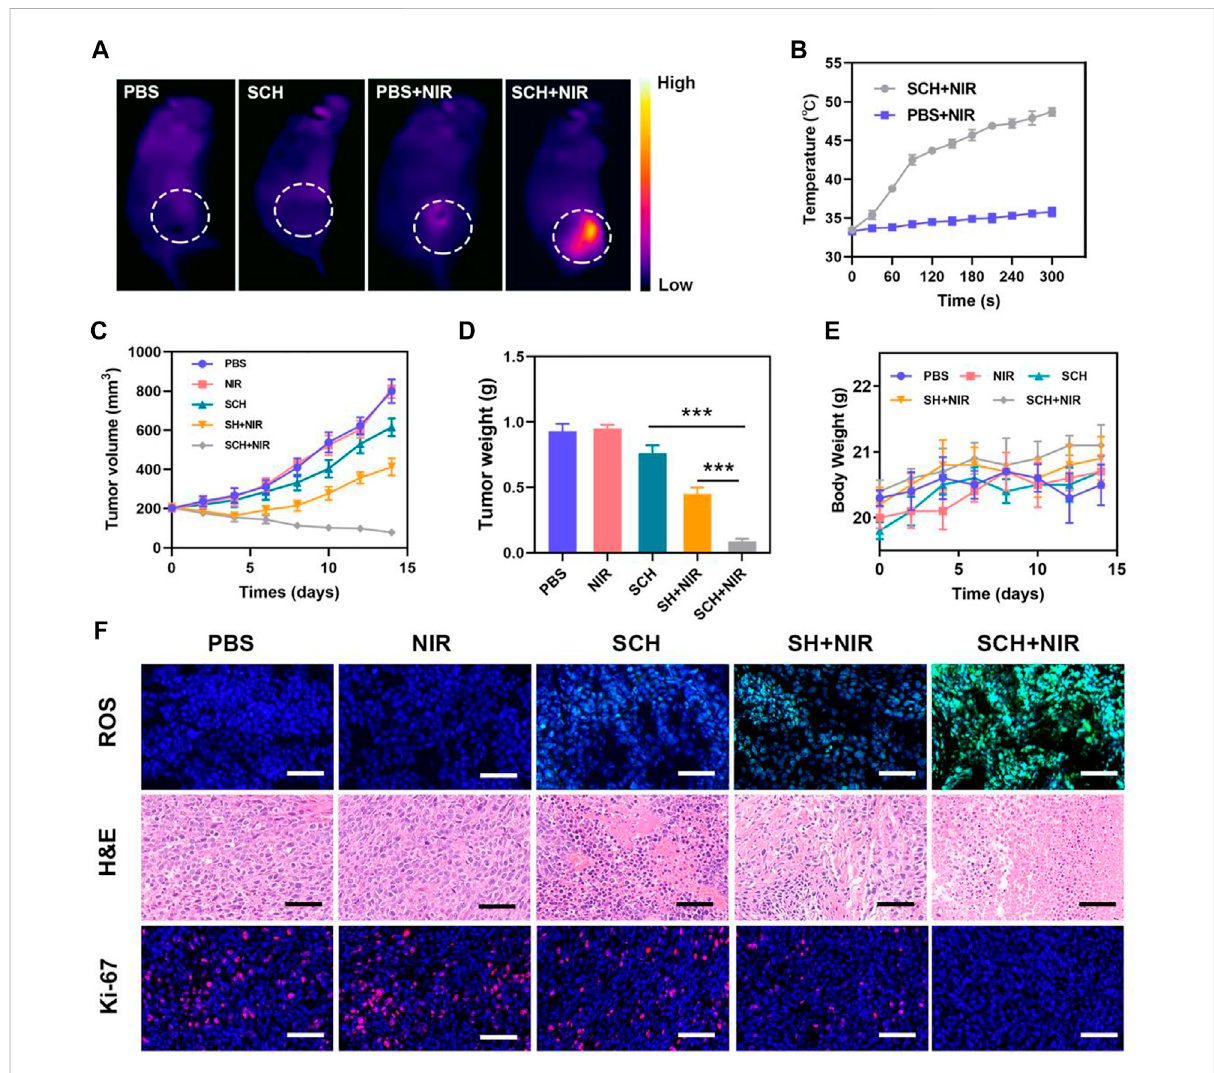
FIGURE 3 (A) Infrared thermal images of tumors in the speci fi ed treatment groups. (B) After being irradiated with 808 nm laser (0.5 W cm − 2 ) for 5 min, the temperature elevates in mice having CT26 tumor, in the speci fi ed treatment groups. (C) The treatment groups ’ tumor volume alters over time, as speci fi ed (n = 5). (D) Average tumor weight values associated with the indicated treatments (n = 5). (E) Changes in body weight in response to the indicated treatments (n = 5). (F) HPF, H&E, and Ki-67-stained tumor sections from the indicated treatment groups (n = 5). Scale bars: 100 μ m *** p < 0.005; Student ’ s t-test. The results were presented as mean ±